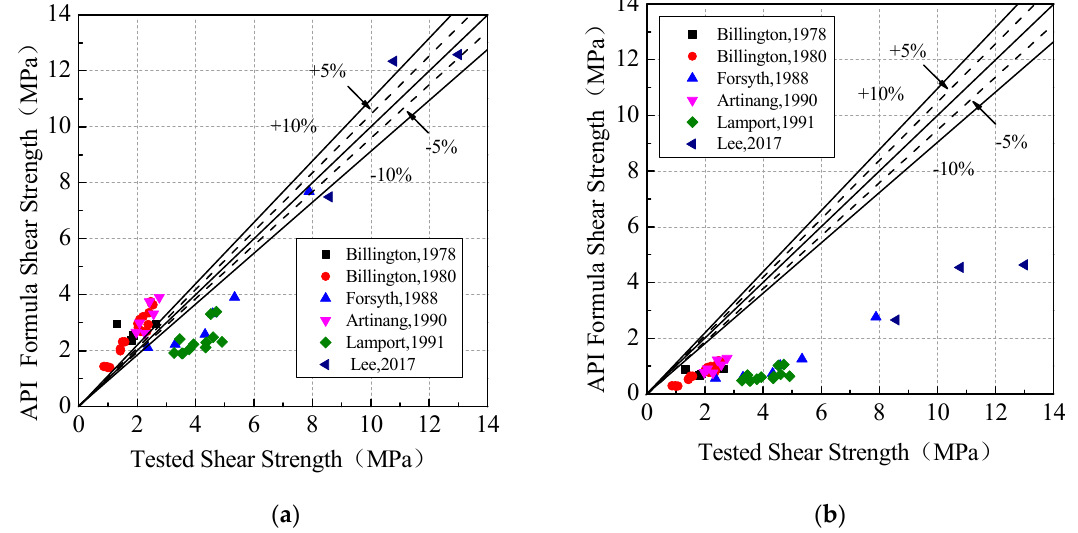
Figure 15. Comparison of shear strength calculated using API and tested results: ( a ) API fitting formula; ( b ) formula under extreme conditions.